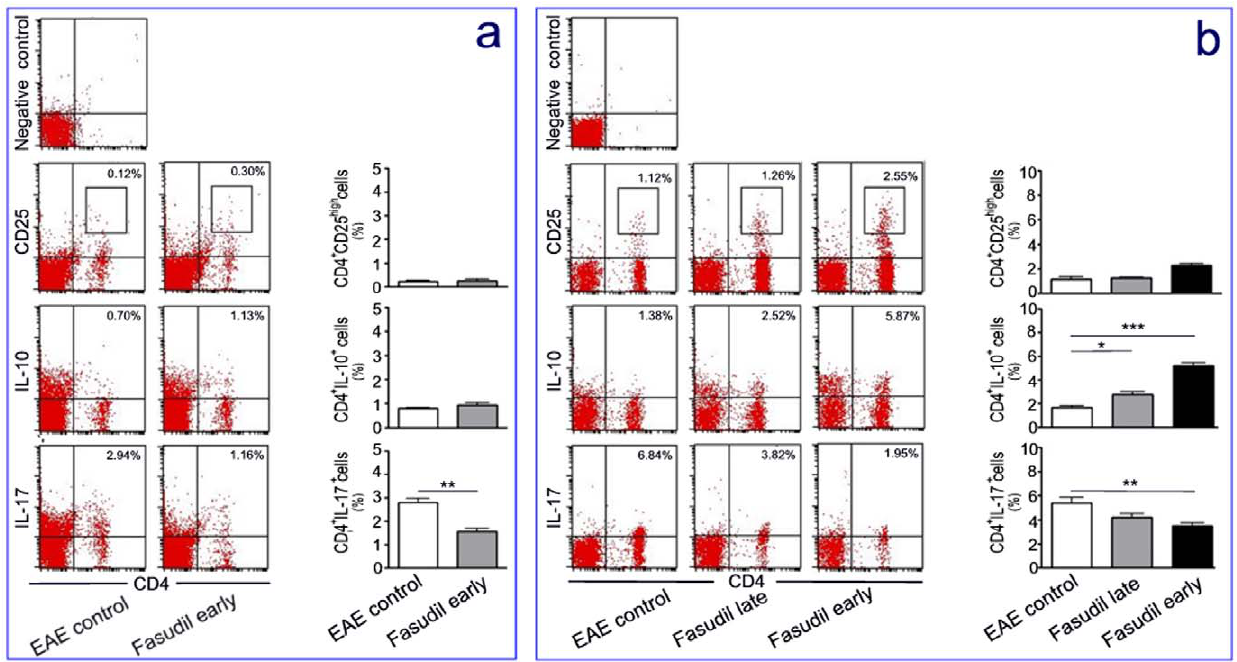
Figure 4. Fasudil induces the regulatory T cells and inhibits IL-17 T cells. Chronic EAE was induced in C57BL/6 mice with MOG 35–55 . Fasudil was injected (i.p.) at 40 mg/kg/d every other day on days 3 and 11 p.i. Mice were sacrificed and splenic MNCs were prepared on days 9 (a) and 21 (b) p.i. Cells were stained with T cell marker CD4 and CD25, IL-10 and IL-17, and subsets of T cells were analyzed using flow cytometry. Scatterplot, representative dot plots from one of three experiments with similar results. Histogram, quantitative results are analyzed for 5 mice in each group. Results are expressed as the percentage of double positive cells in four-quadrant diagram or within rectangle. * p , 0.05, ** p , 0.01, *** p , 0.001.